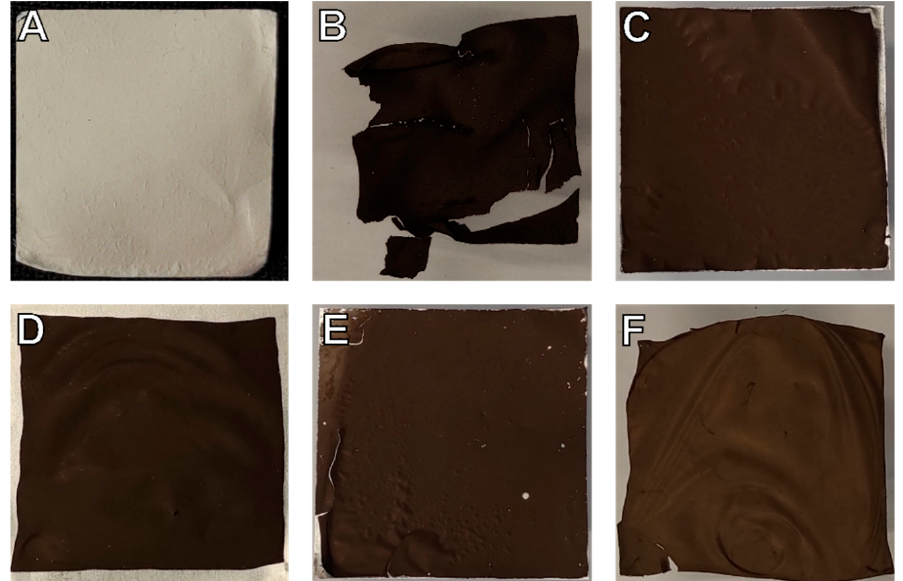
Figure 4. Exemplary photos of the samples: ( A ) PP-E, ( B ) PP-C, ( C ) AL-C, ( D ) AL-SW1-C, ( E ) AL-SW2-C, and ( F ) STS-SW-C.